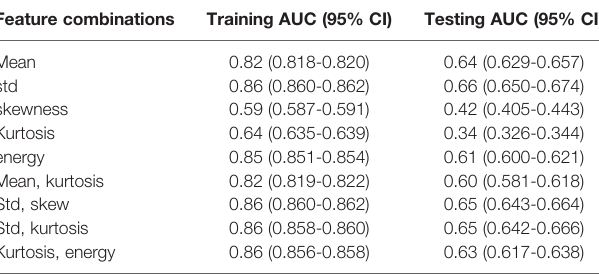
TABLE 4 | Training and testing AUC values for US-GLM classi fi ers developed using different combinations of weakly correlated features. Feature combinations